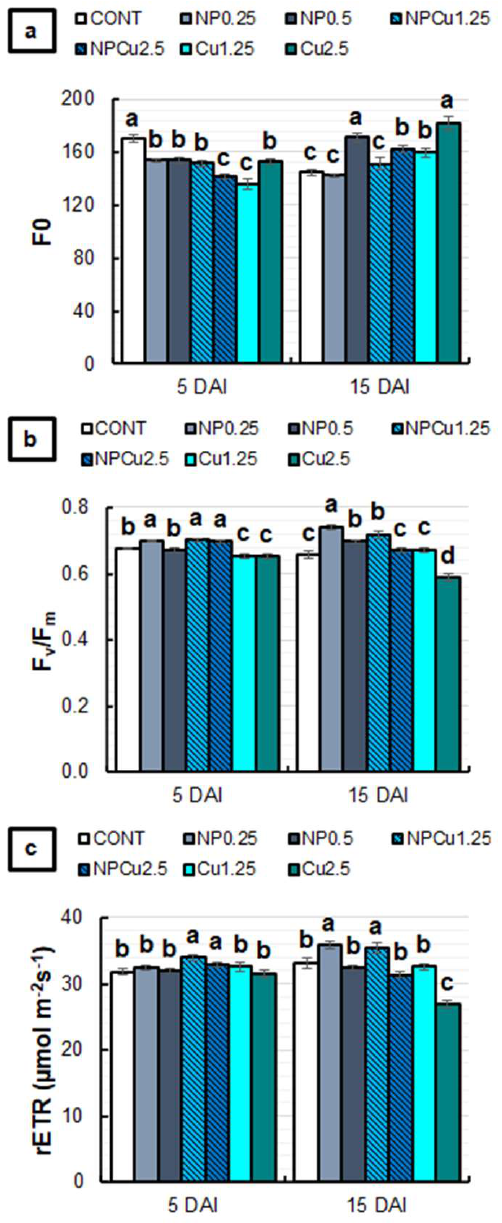
Figure 8. F 0 ( a ), F v /F m ( b ), and rETR ( c ) of leaf discs of Coffea arabica cv. IPR 100 at 5 and 15 days after infection (DAI) with H. vastatrix . Before infection, the discs were treated with distilled water as a control (CONT), chitosan nanoparticles without Cu 2+ ions (NP), chitosan nanoparticles containing Cu 2+ ions (NPCu), and free Cu 2+ ions (Cu). The formulations were diluted in distilled water, obtaining the corresponding concentrations of chitosan (CS) in NP and NPCu treatments (0.25; 0.5 g L − 1 ) and of Cu 2+ ions (1.25; 2.5 mmol L − 1 ) in NPCu and Cu treatments. Results are expressed as mean ( n = 4) ± standard error. Equal letters in the columns indicate that there was no significant difference in the Scott–Knott test ( p < 0.05) at the same time